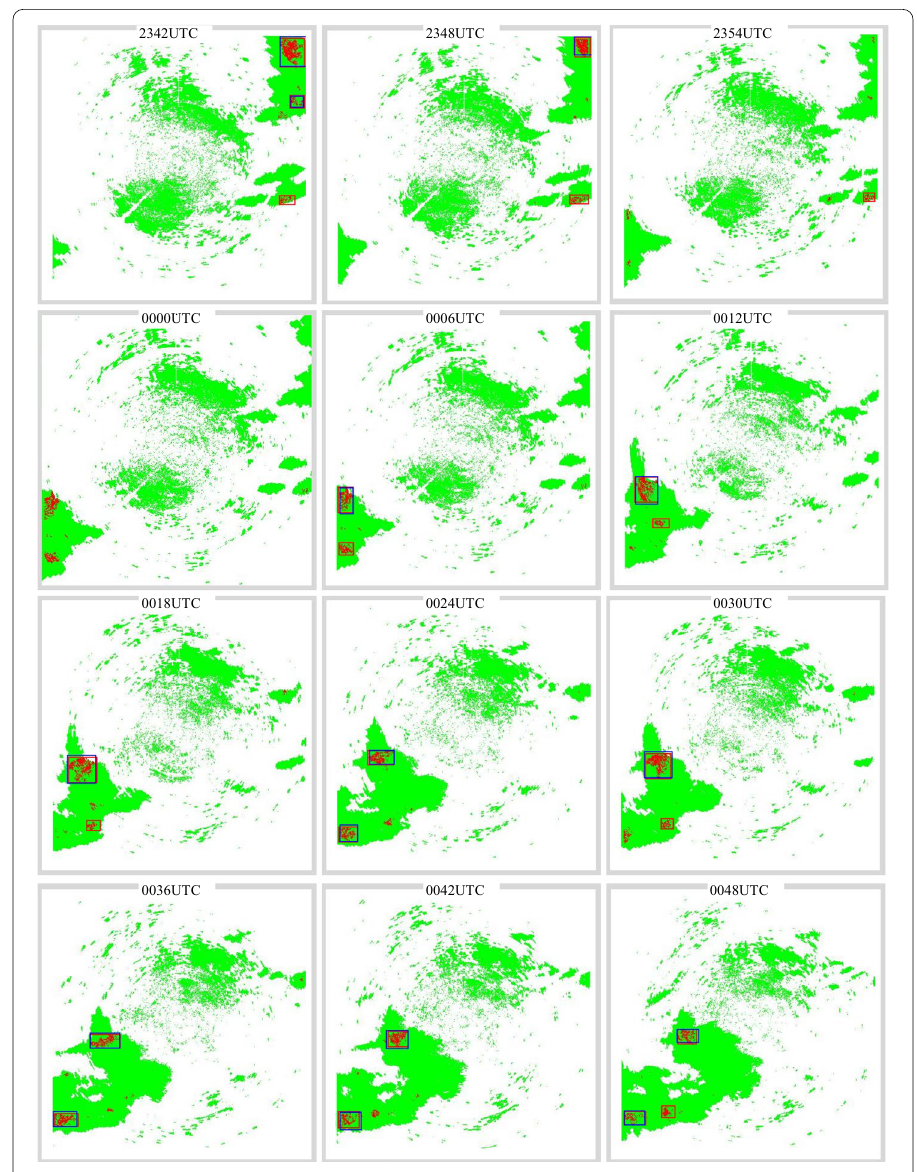
Fig. 15 The identification results of precipitation clouds corresponding to 2342UTC-0054UTC